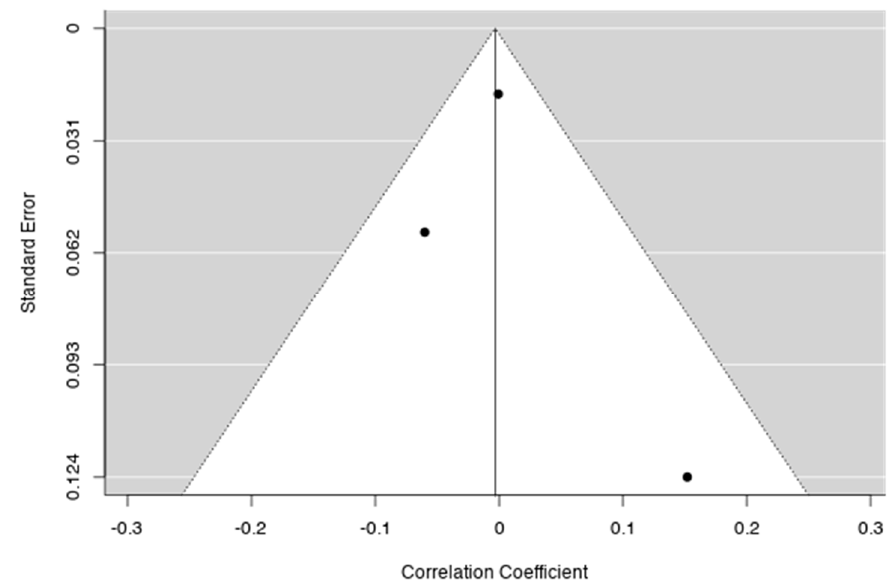
Figure 4. Funnel plot of the meta-analysis in schizophrenia patients. Each plotted point represents the standard error and the correlation coefficient between the SZ PRS and global cognitive functioning for a single study. The white triangle represents the region where 95% of the data points would lie in the absence of a publication bias. The vertical line represents the average correlation coefficient found in the meta-analysis.